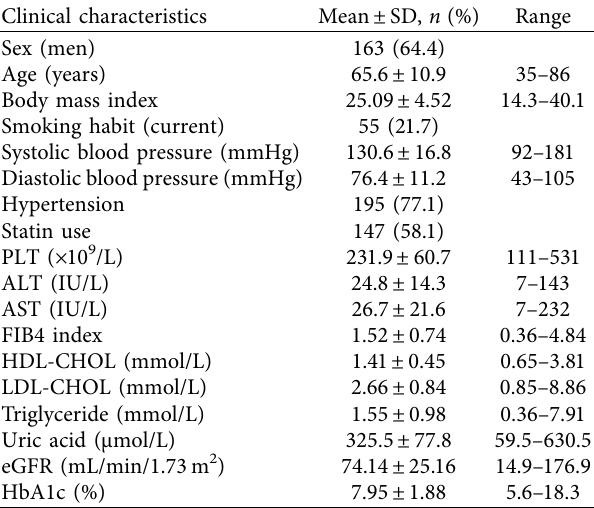
Table 1: Clinical characteristics of study subjects. Clinical